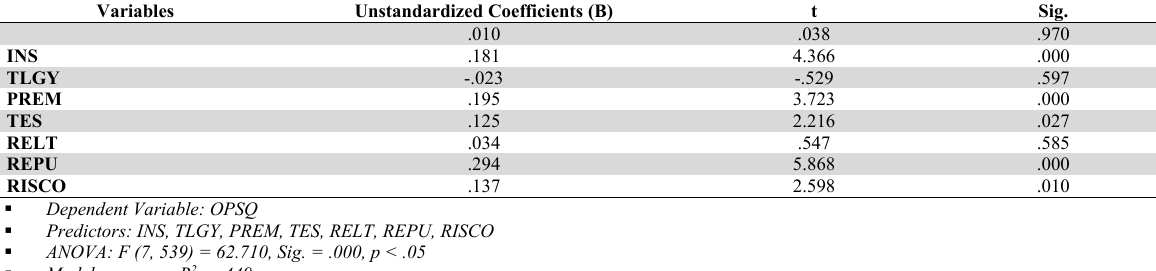
Coefficients between Independent Variables and